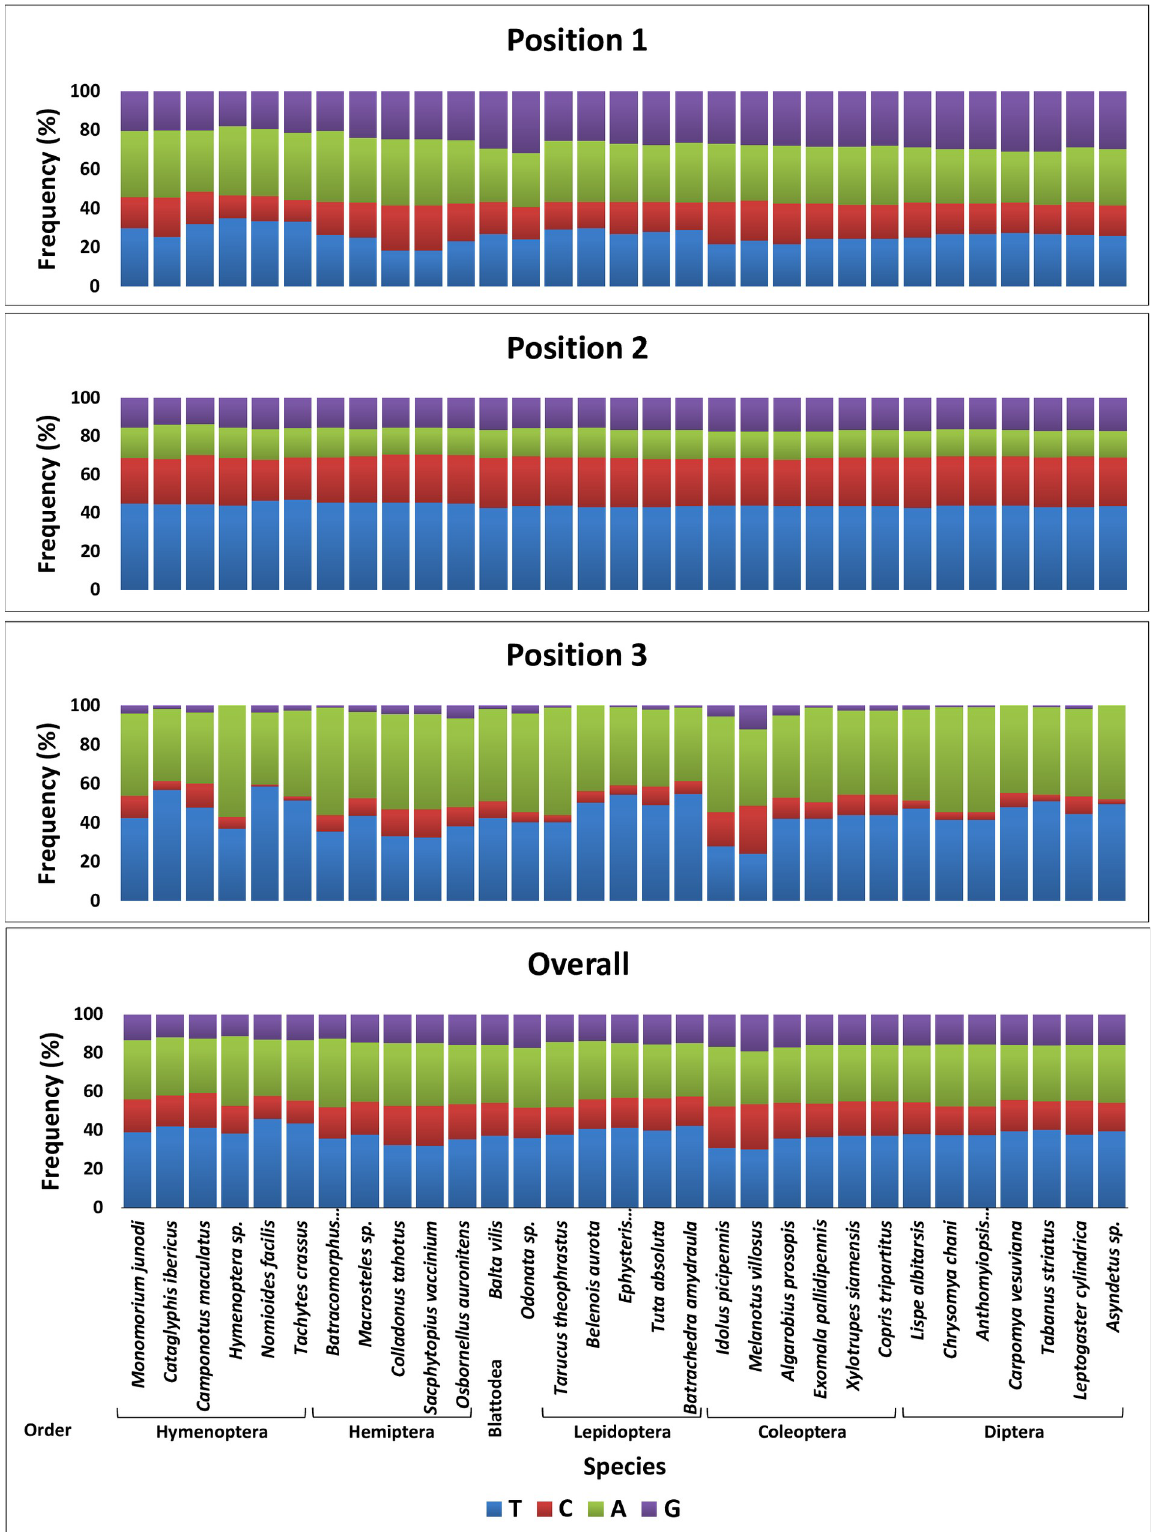
Fig 1. Distribution of nucleotides within codons across six insect orders. Nucleotide frequencies at each of the three codon positions in COI barcode sequence of species of six insect orders in addition to an Odonata sp. used for comparison. https://doi.org/10.1371/journal.pone.0224336.g001 PLOS ONE | https://doi.org/10.1371/journal.pone.0224336 November4,